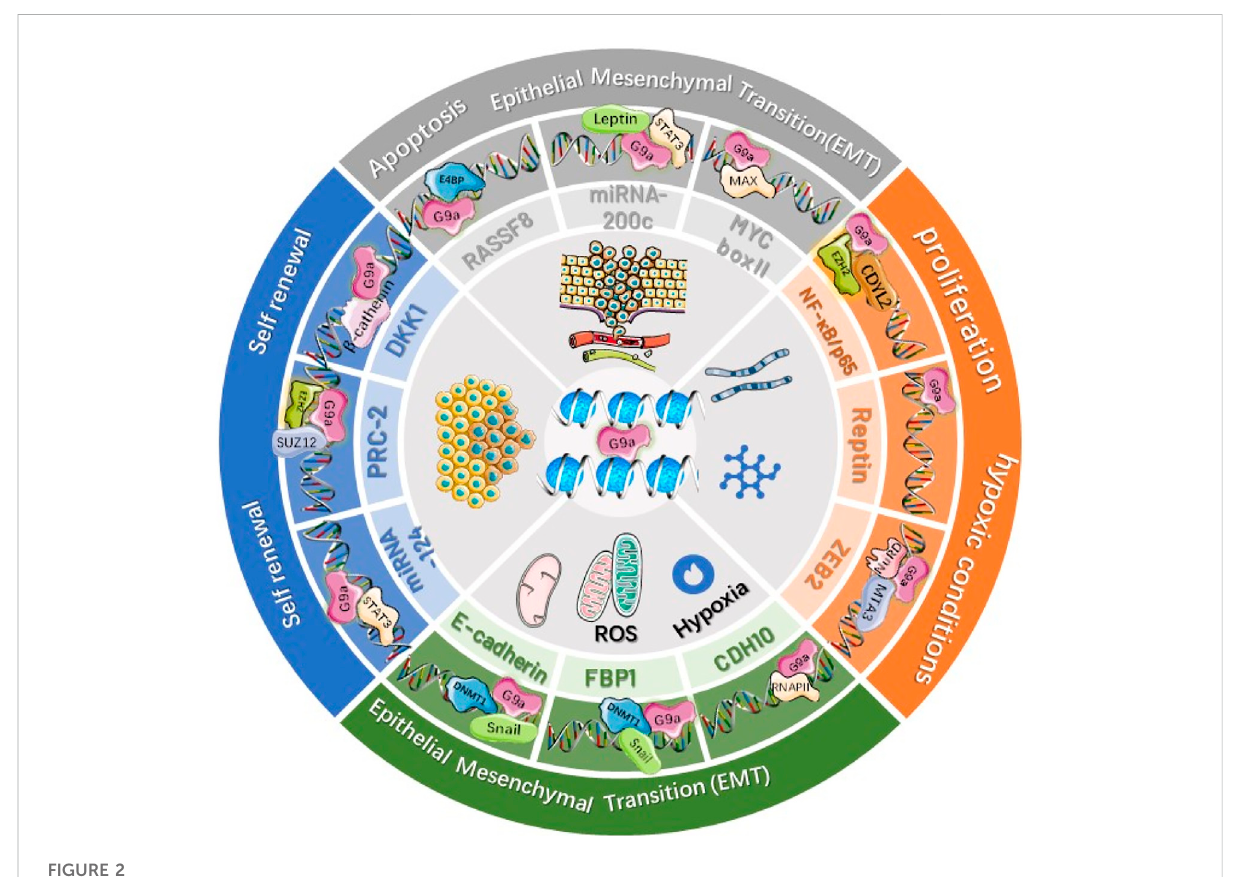
FIGURE 2 Dysregulation of G9a in various breast